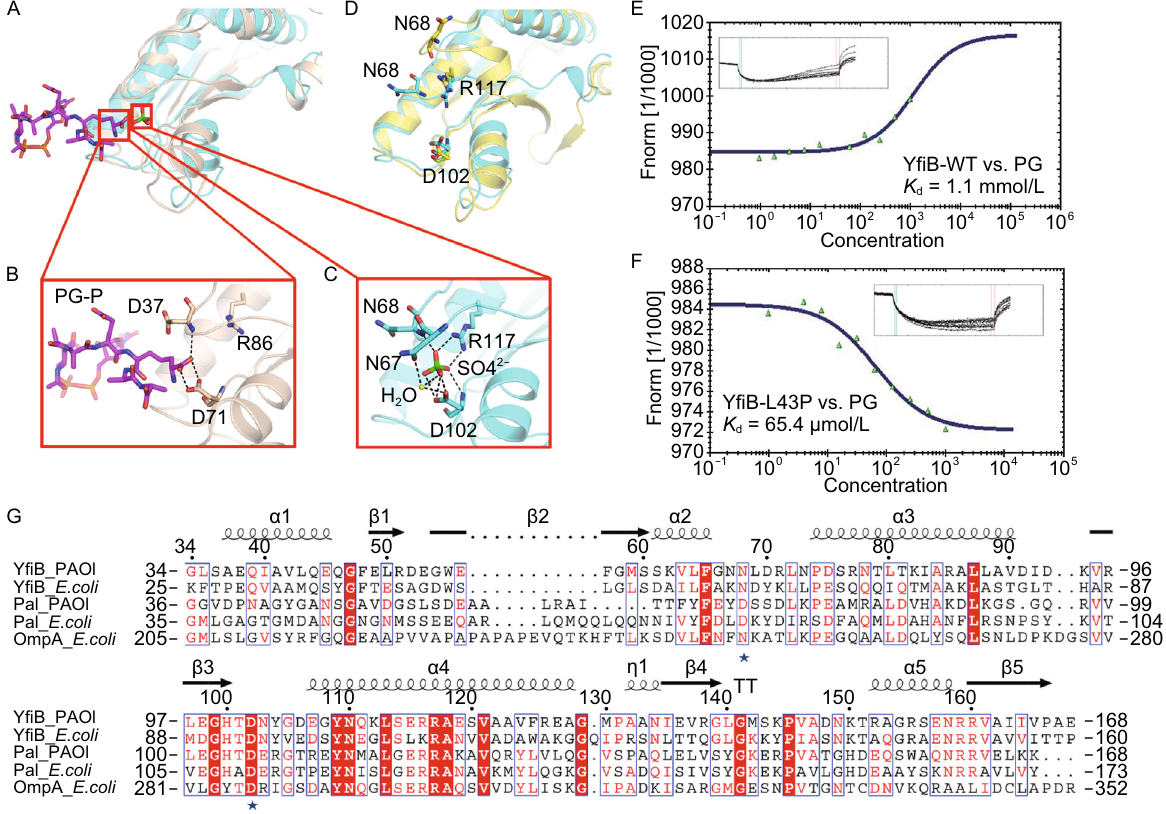
Figure 4. The PG-binding site in Y fi B. (A) Structural superposition of the PG-binding sites of the H. in fl uenzae Pal/PG-P complex and Y fi R-bound Y fi B L43P complexed with sulfate ions. (B) Close-up view showing the key residues of Pal interacting with the m -Dap5 ε -carboxylate group of PG-P. Pal is shown in wheat and PG-P is in magenta. (C) Close-up view showing the key residues of Y fi R- bound Y fi B L43P interacting with a sulfate ion. Y fi R-bound Y fi B L43P is shown in cyan; the sulfate ion, in green; and the water molecule, in yellow. (D) Structural superposition of the PG-binding sites of apo Y fi B and Y fi R-bound Y fi B L43P , the key residues are shown in stick. Apo Y fi B is shown in yellow and Y fi R-bound Y fi B L43P in cyan. (E and F) MST data and analysis for binding af fi nities of (E) Y fi B wild-type and (F) Y fi B L43P with PG. (G) The sequence alignment of P. aeruginosa and E. coli sources of Y fi B, Pal and the periplasmic domain of